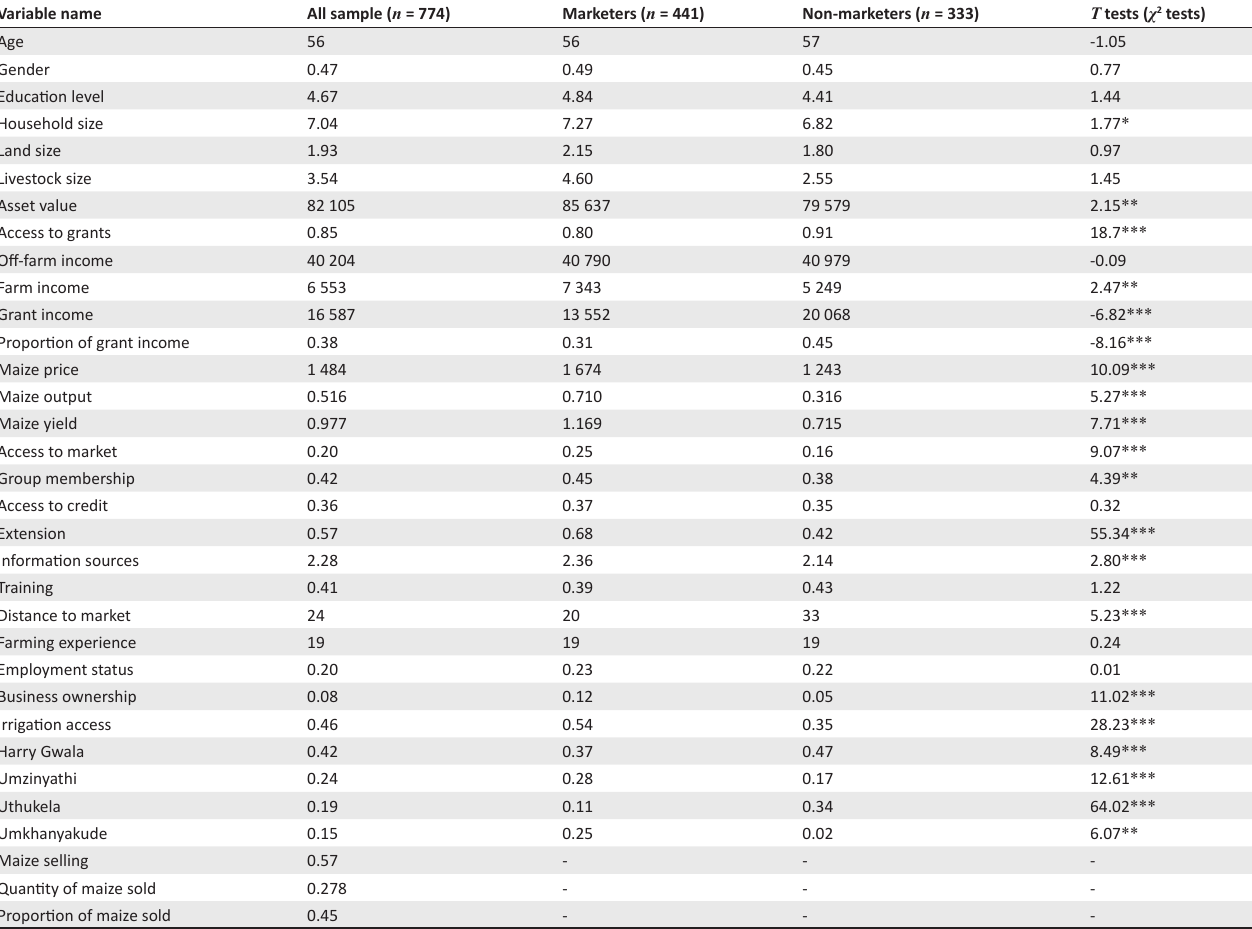
TABLE 2: Socio-economic characteristics of the sampled households according to maize market participation status ( n = 774). Variable